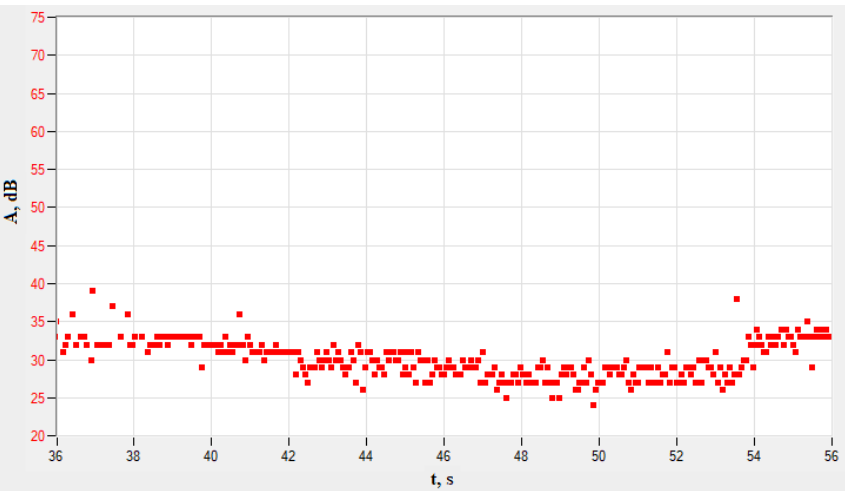
Figure 6. An example of changing average amplitude value as a function of time for Sample No. 3 (PAC system).